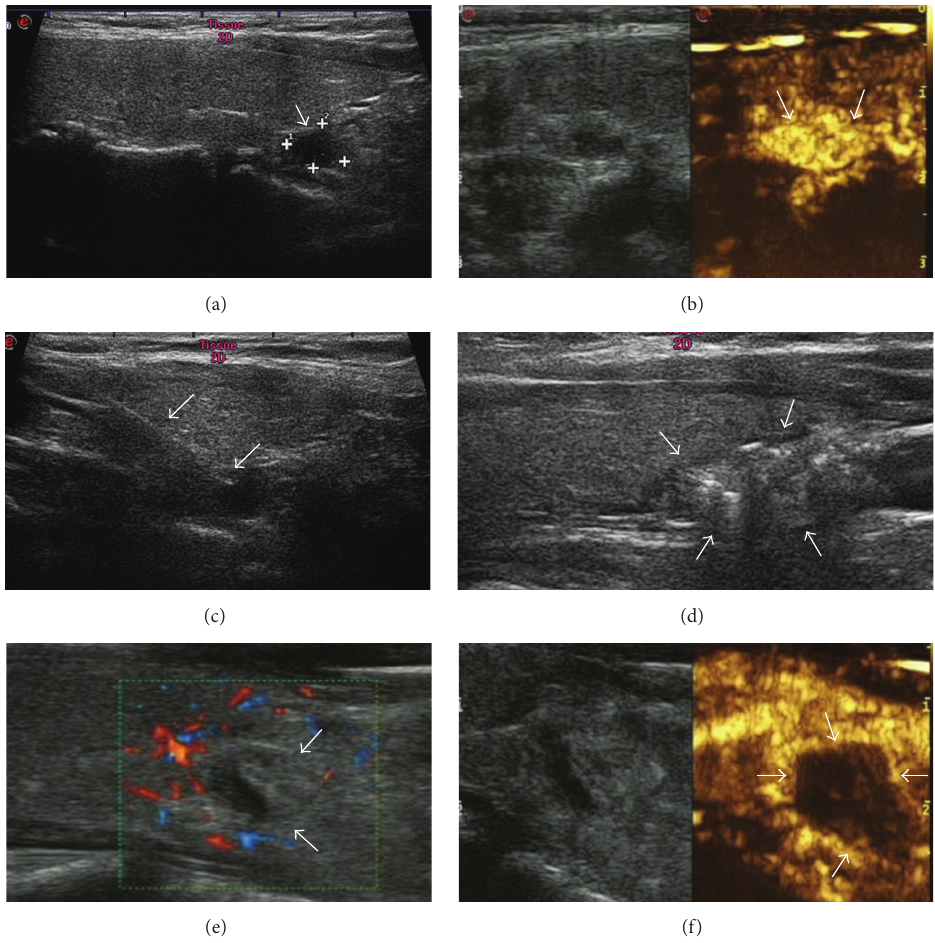
Figure 1: Representative ultrasonography images from one patient, a 45-year-old woman with parathyroid adenoma and hyperparathy- roidism, illustrating the LA procedure. (a) Longitudinal section of the right neck revealed a 0.21 mL enlarged parathyroid gland (arrow and cursors) situated posterior to the inferior portion of the right lobe of the thyroid gland. (b) Preablation CEUS demonstrated hyperenhancement of the parathyroid lesion. (c) Ultrasonography image showing a 21-gauge needle inserted into the parathyroid; the arrows point to the needle tip. (d) During the LA procedure, the tissue around the fiber tip became hyperechoic (arrows) under US monitoring, and the hyperechoic area gradually enlarged until the nodule became filled with hyperechogenicity. This LA process was repeated throughout the parathyroid gland until most of gland had been ablated. (e) The color Doppler image obtained 1 hour after ablation showed no flow signal in the ablated area (arrows). (f) After the procedure had been completed, CEUS showed no enhancement of the ablated area by the contrast agent